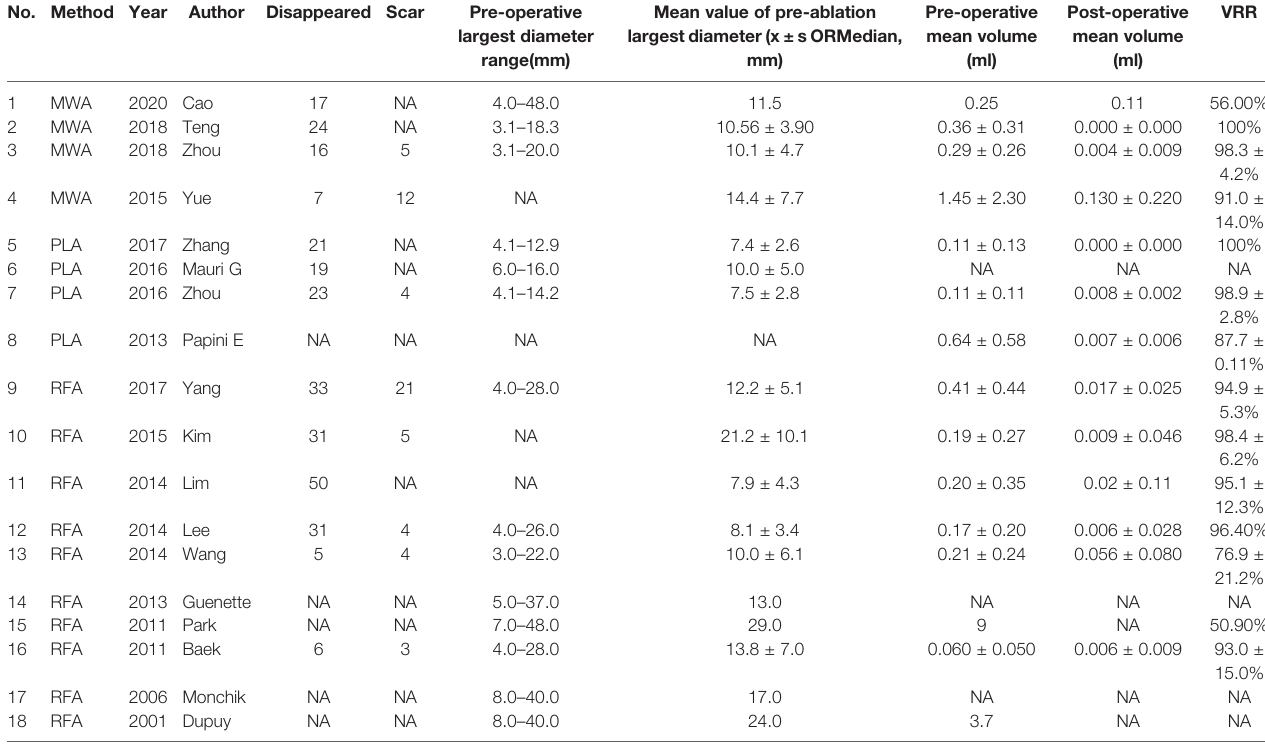
TABLE 2 | Volume Reduction Rate of Included Studies in this Review.